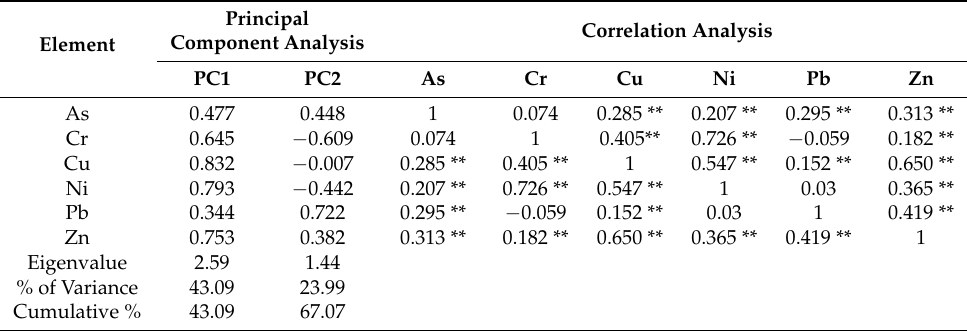
Table 3. PCA loadings and correlation coefficients of trace metals in the soils of the Golden Triangle. Principal Correlation Analysis Component Analysis Element PC1 PC2 As Cr Cu Ni Zn As 0.477 0.448 0.074 0.285